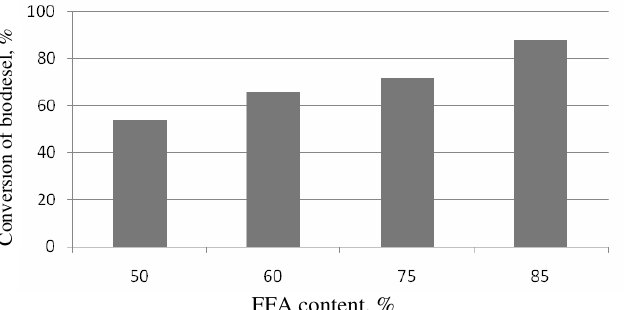
Figure 4. Effect of Free Fatty Acid content on biodiesel